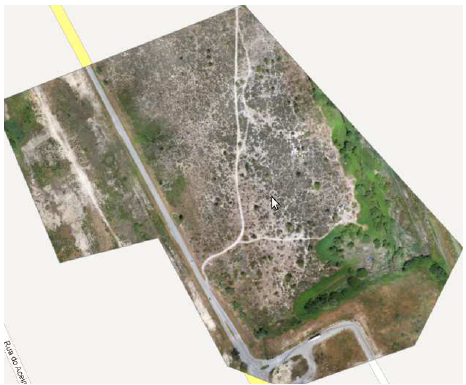
Figure 2: Example of an orthomosaic obtained from a set of aerial photographs with an average resolution of 6.9cm, obtained using the Spin.Works S-20 system.